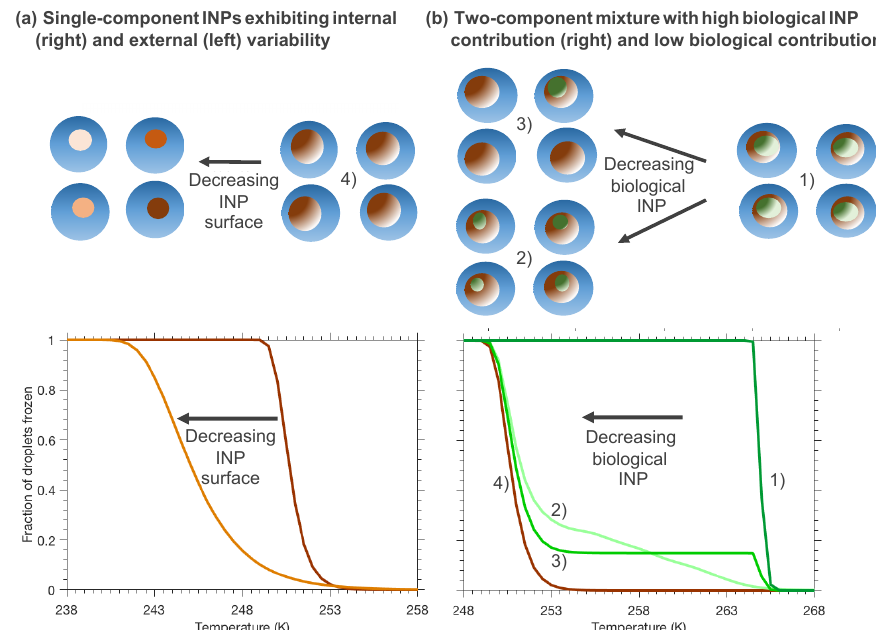
Figure 1. (a) Top right: droplets containing particle surfaces larger than the component’s critical surface area exhibiting internal variability (color gradient) in HIN activity. Top left: droplets contain particle surfaces smaller than the component’s critical surface area and exhibit external variability in HIN depicted by the different colors. Bottom: decreasing surface area leads to higher external variability in HIN activity and thus a wider range over which droplets freeze. (b) Top right: droplets contain a mixture of mineral dust (brown) and biological (green) particle surfaces, both of which are larger than their component’s critical surface area. Top left: two hypothetical scenarios of reduced biological particle surface areas are depicted as the concentration of biological INP is reduced. In scenario 2 the biological material distributes itself equally among the droplets and thus remains internally mixed, while in scenario 3 the biological material does not further partition itself further and becomes externally mixed. Scenario 4 represents the absence of any biological material (top right corner of a ) and the resultant temperature freezing spectrum is identical to the one for dust lying above its critical surface area shown in the bottom of (a) . Bottom: the predicted impact of the INP concentration and mixing state of the bio-dust mixture on the resultant freezing spectrum of droplets containing the particle